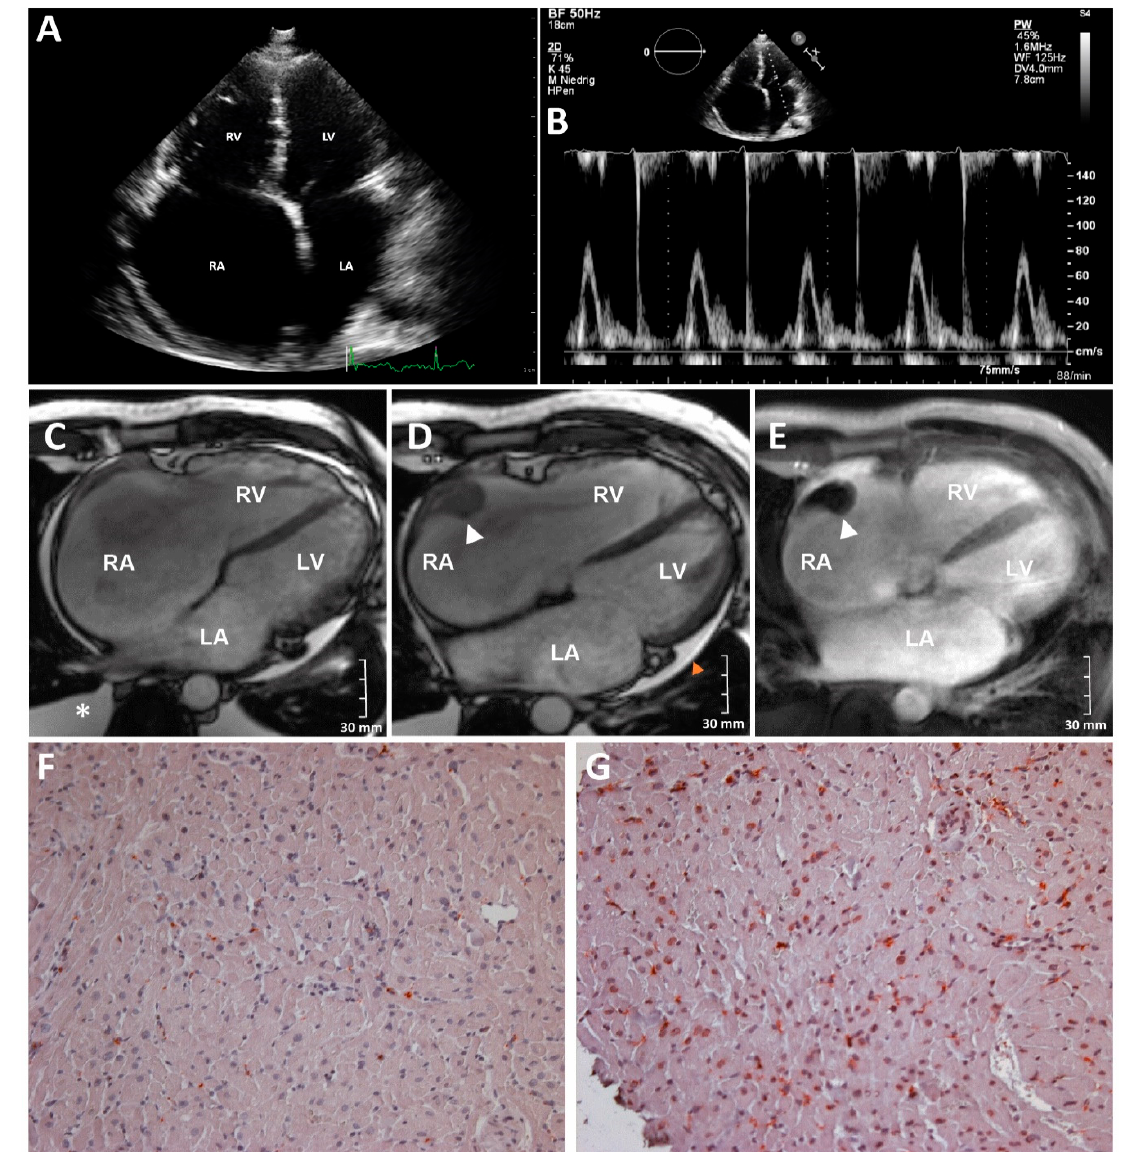
Figure 1. Clinical findings in index patient III-9 with RCM and persistent atrial fibrillation. ( A ) 2D transthoracic echocar- diography. Apical four chamber view. Note enlargement of both atria with relatively small ventricles. A small amount of pericardial effusion is also visible. ( B ) Transthoracic echocardiography. Apical four chamber view, PW-Doppler of the mitral valve inflow. ( C-E ) Cardiac magnetic resonance imaging of III-9. ( C,D ) End-diastolic cine steady-state free-preces- sion acquisitions. ( E ) Early 3D inversion-recovery T1-weighted fast gradient-echo for thrombus detection. (RA = right atrium; LA = left atrium; RV = right ventricle; and LV = left ventricle. A wall-adherent thrombus in the RA (34 × 25 × 17 mm) is marked with a white arrow head. Pericardial effusion (orange arrow head) was present, and pleural effusion (as- terisk) was detected. ( F , G ) Immunohistology analysis of a right ventricular biopsy revealed myocardial inflammation. (200× magnification) ( F ) CD68 staining revealed increased number of macrophages. ( G ) CD45R0 staining revealed in- creased number of activated T-cells.